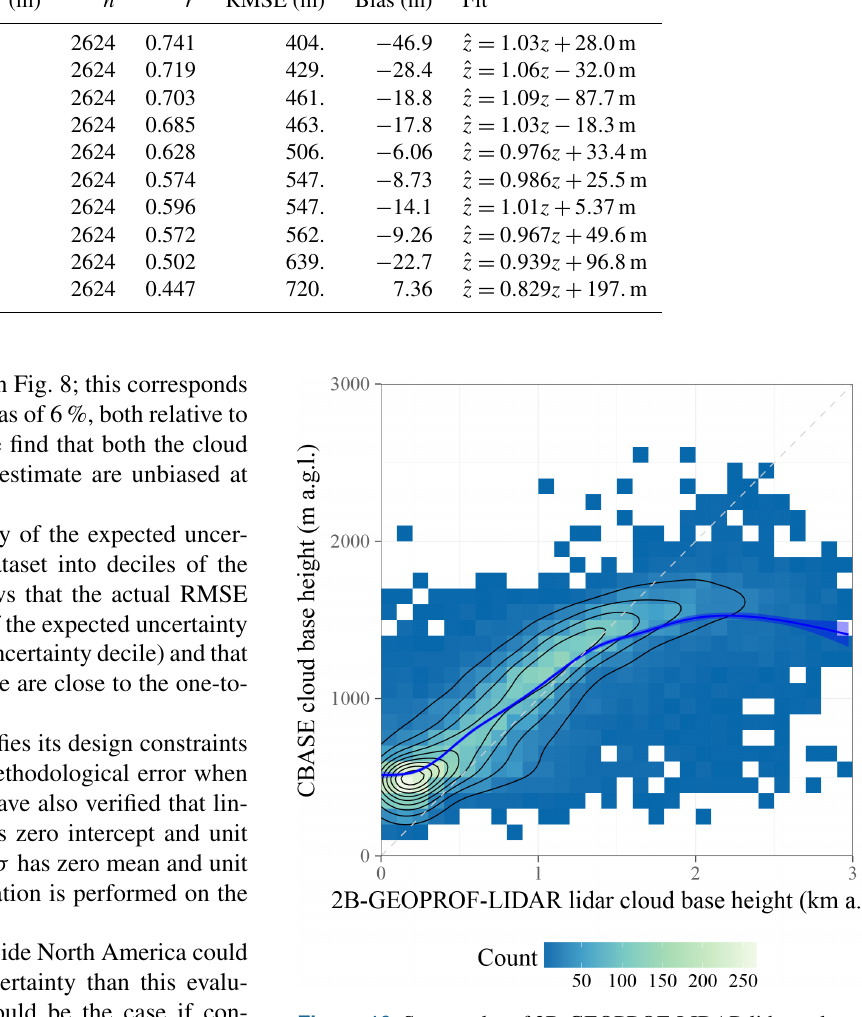
Comparison with 2B-GEOPROF-LIDAR cloud bases (ver- sion P2_R04_E02, based on the 2B-GEOPROF and